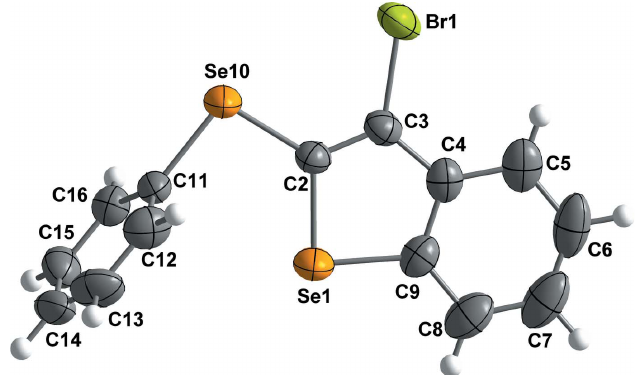
Figure 3 The molecular structure of 3-bromo-2-(phenylselanyl)benzo[ b ]seleno- ]selenophene ( 3 ), with displacement ellipsoids drawn at the 50% probability level.